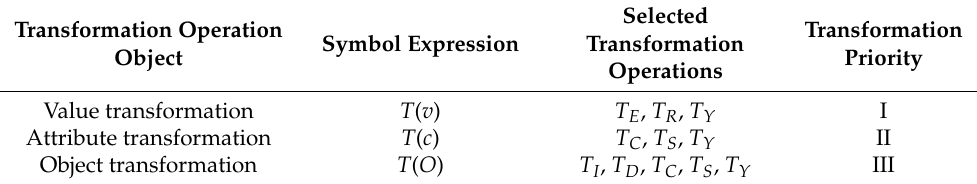
Table 1. Type of transformation